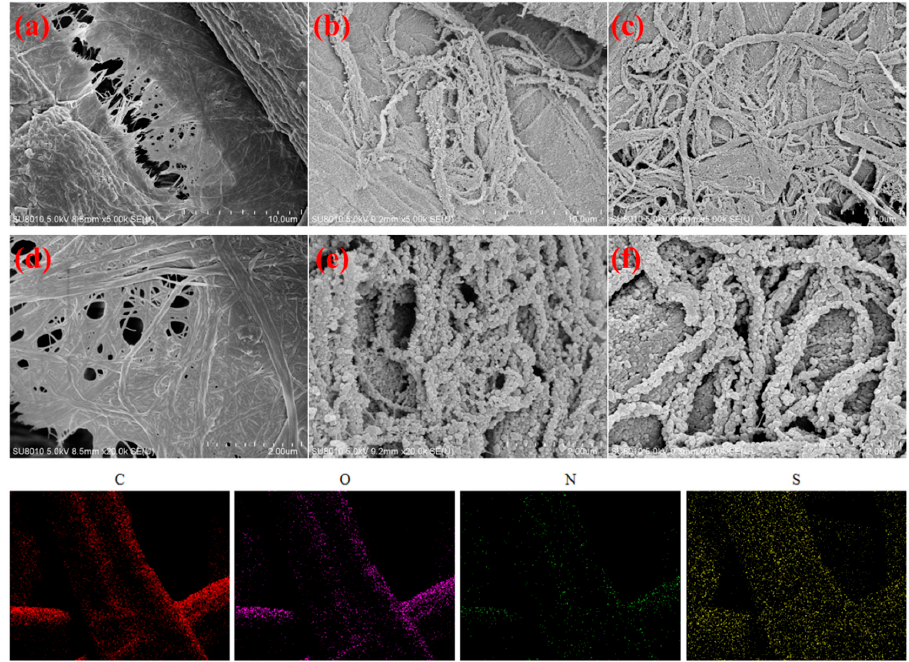
Figure 2. SEM images of CFs ( a , d ), PPy@CFs ( b , c ), and PPy:AQS/p-TSA@CFs ( e , f ) electrode materials and EDS element analysis ( C , O , N , and S ) images of PPy:AQS/p-TSA@CFs electrode materials. Figure 3a illustrated the XRD patterns of CFs, PPy@CFs, and PPy:AQS/p-TSA@CFs composites. From the position of the peaks, there is no significant difference between the three. The peaks at 15.6° and 22.5° in the XRD pattern correspond to the (110) and (200)